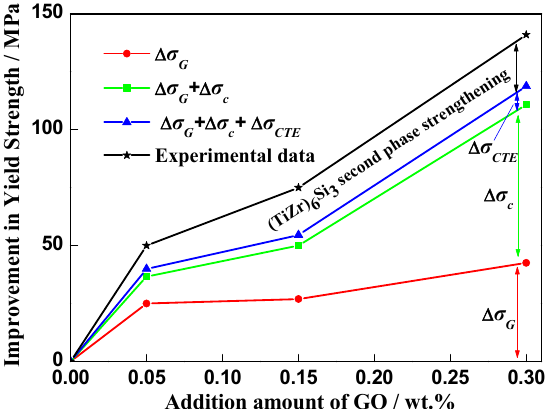
Figure 13. Improvement in yield strength of composites at room temperature.